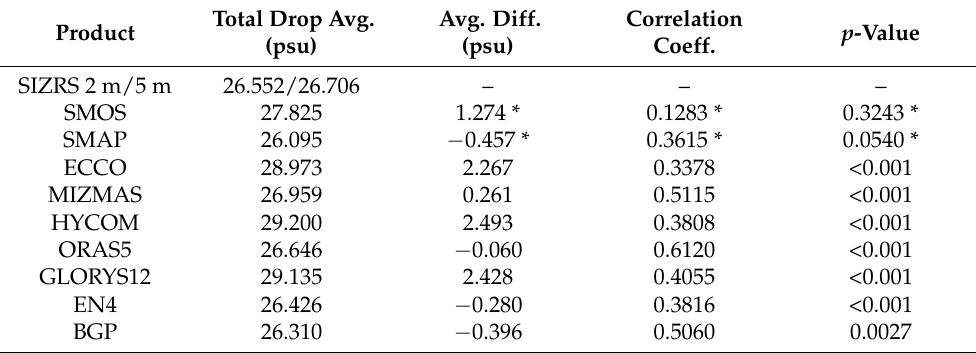
Table 2. Statistical analysis including the total drop average, the average difference, the correlation coefficient, and the p -value of sea surface salinity (psu) between SIZRS other salinity products at each SIZRS drop point. Total Drop Avg. Avg. Diff. Product (psu) (psu) Coeff.